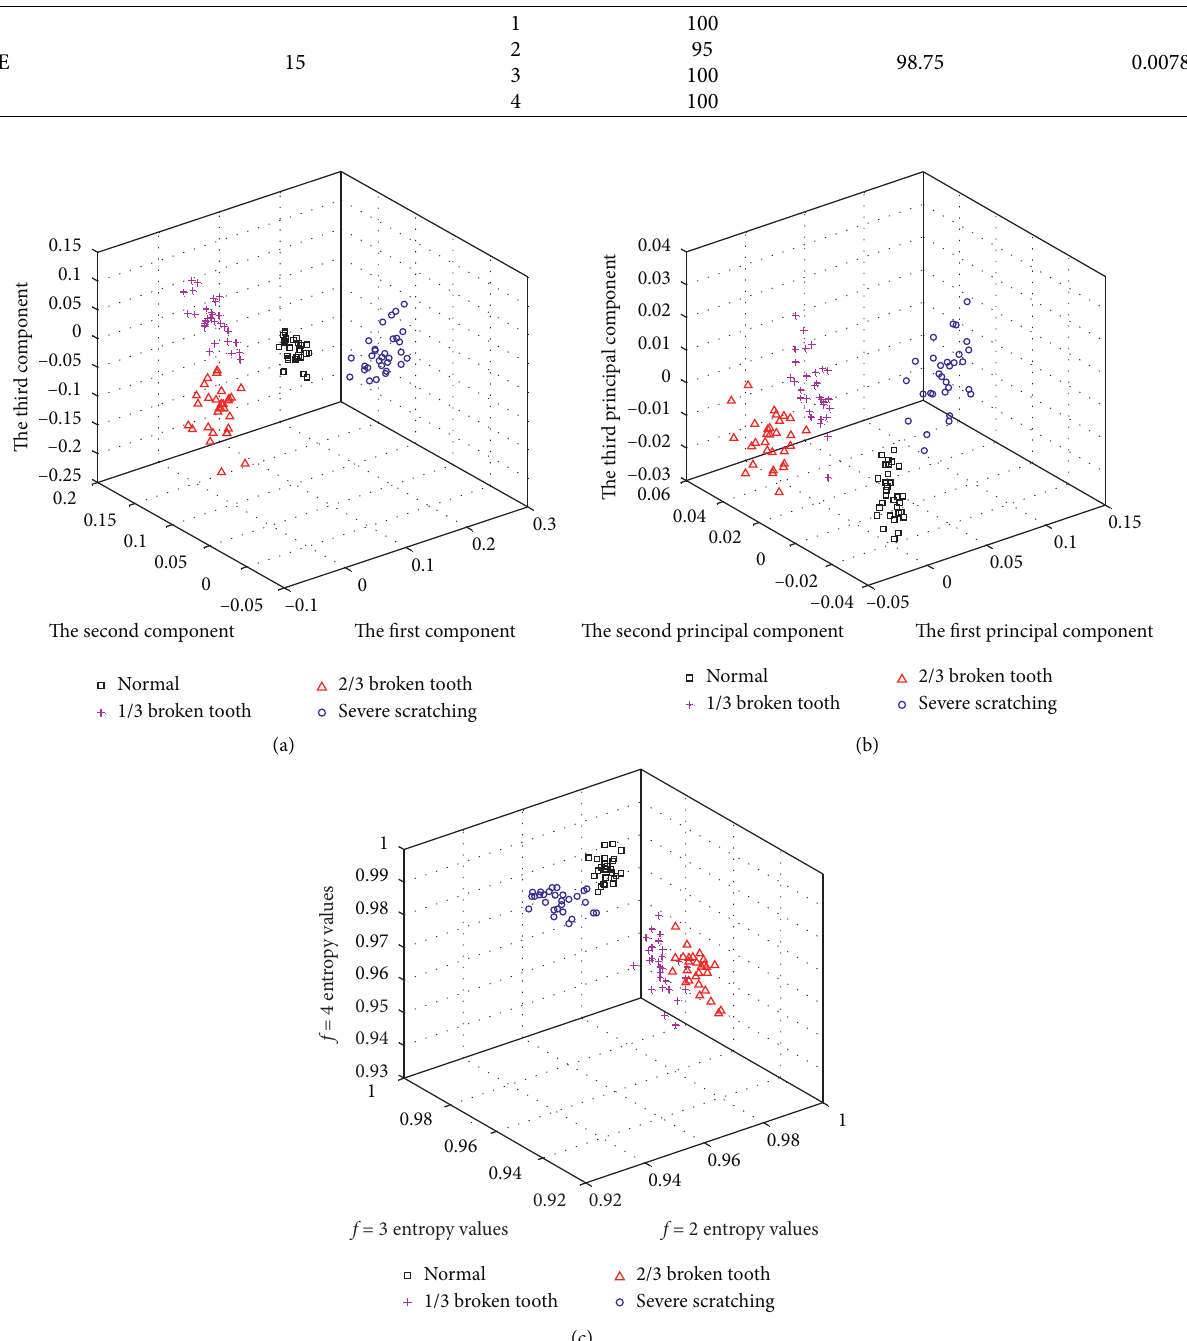
Figure 10: The 3D map at speed of 1,200r/min. (a) The 3D map of MPE-LPP. (b) The 3D map of MPE-PCA. (c) The 3D map of